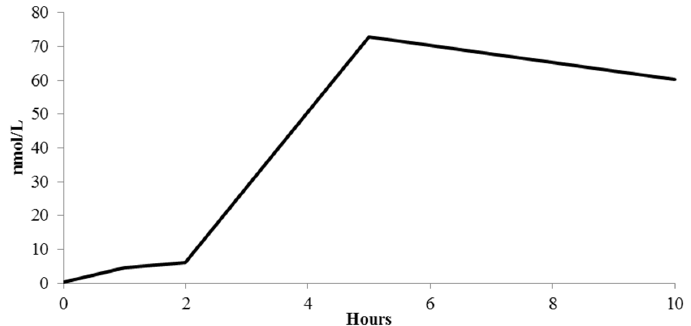
Figure 5. Total concentration of all circulating (poly)phenol metabolites, excluding hippuric acid, 4-hydroxyhippuric acid, and feruloylglycine. Data are expressed as mean